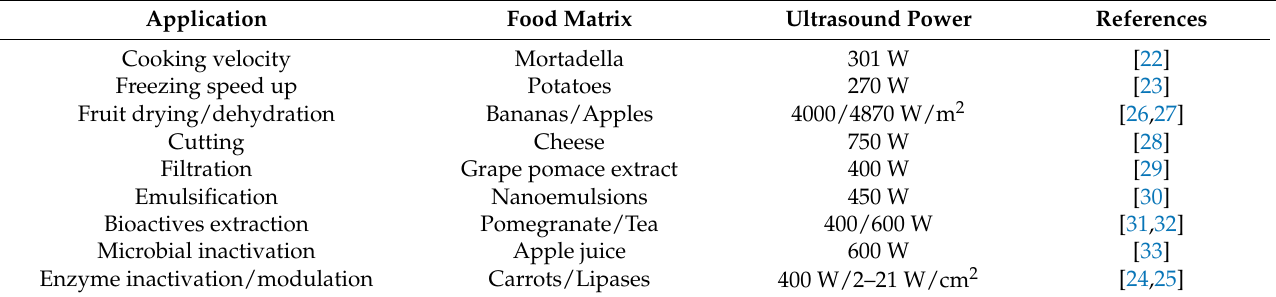
Table 1. The main applications of ultrasound in the food